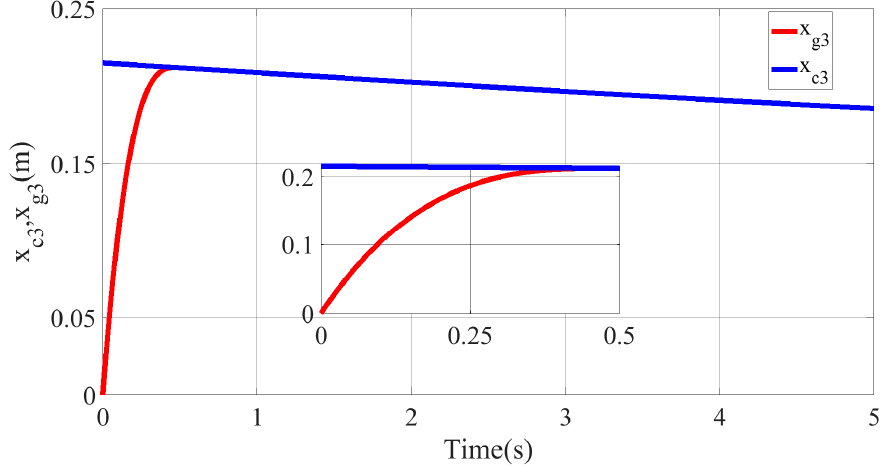
Figure 11. Motion curves before and after trajectory reconstruction.